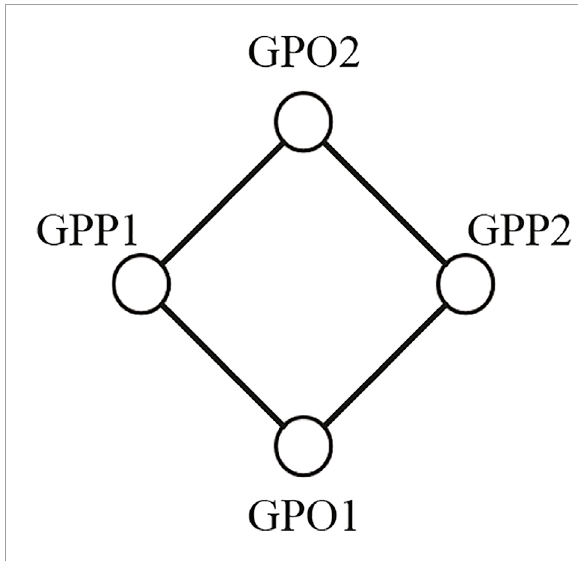
FIGURE1 The topology diagram of two GPOs and two GPPs.